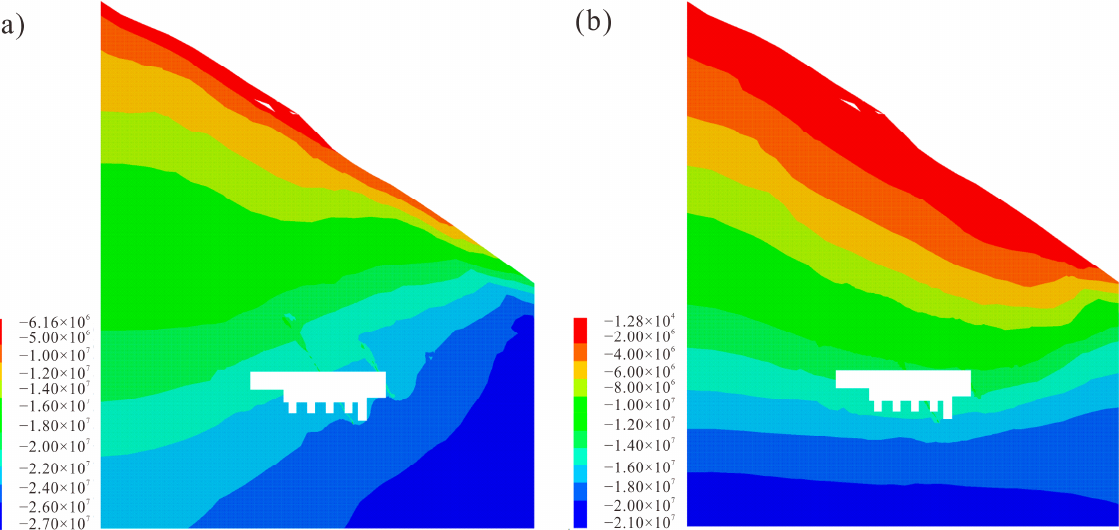
Figure 8. Stress distribution in the longitudinal section of the main powerhouse. ( a ) the first principal stress; and ( b ) the third principal stress.